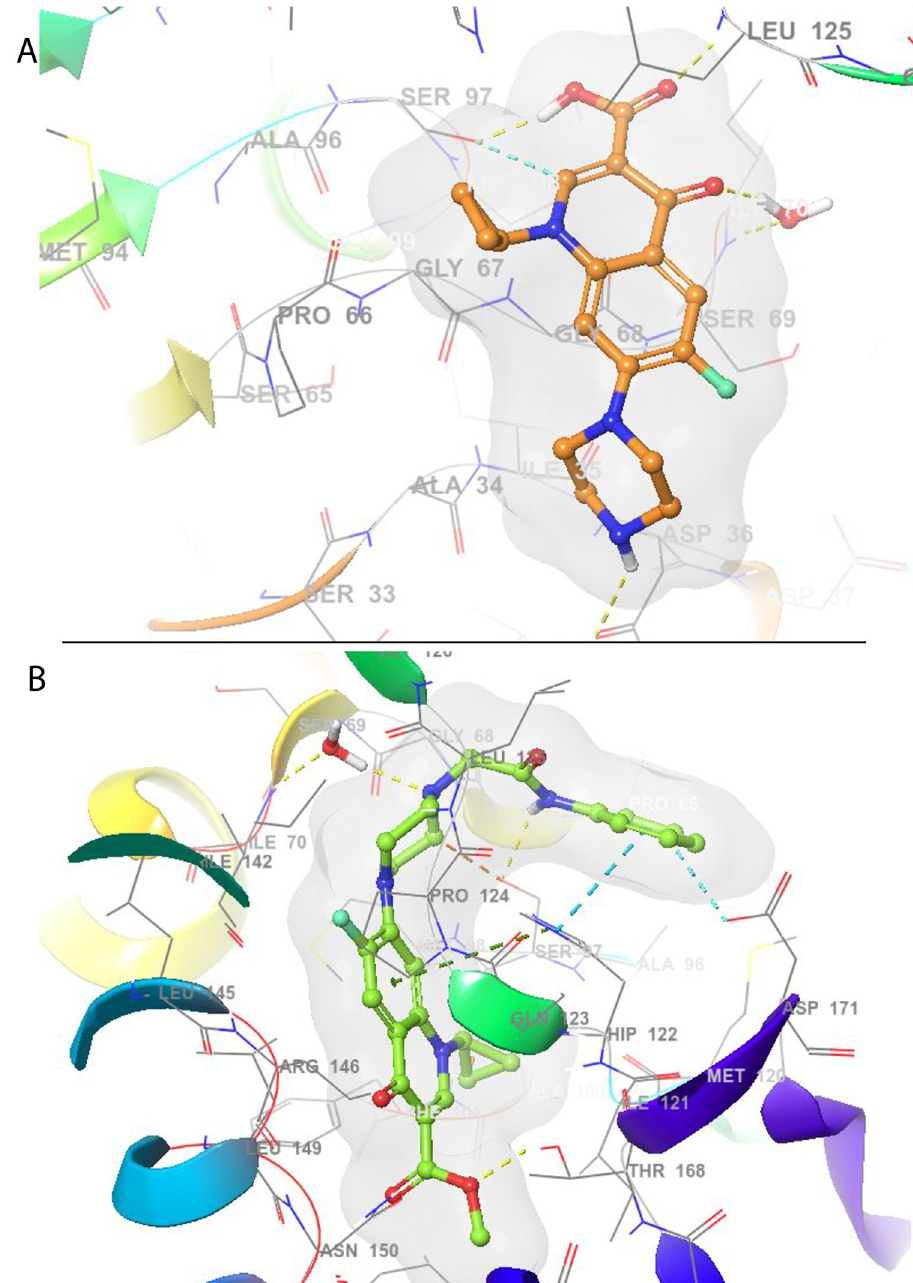
Fig 9. Conformational analysis of ligands at the active site of protease. Simulated best binding mode of ciprofloxacin (A) and compound 4a (B) Induced Fit docked into binding pocket.